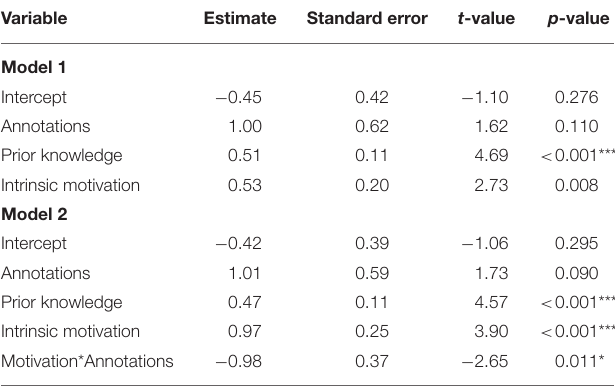
TABLE 3 | Multiple regression model including prior knowledge, intrinsic motivation, and overall learning outcome.